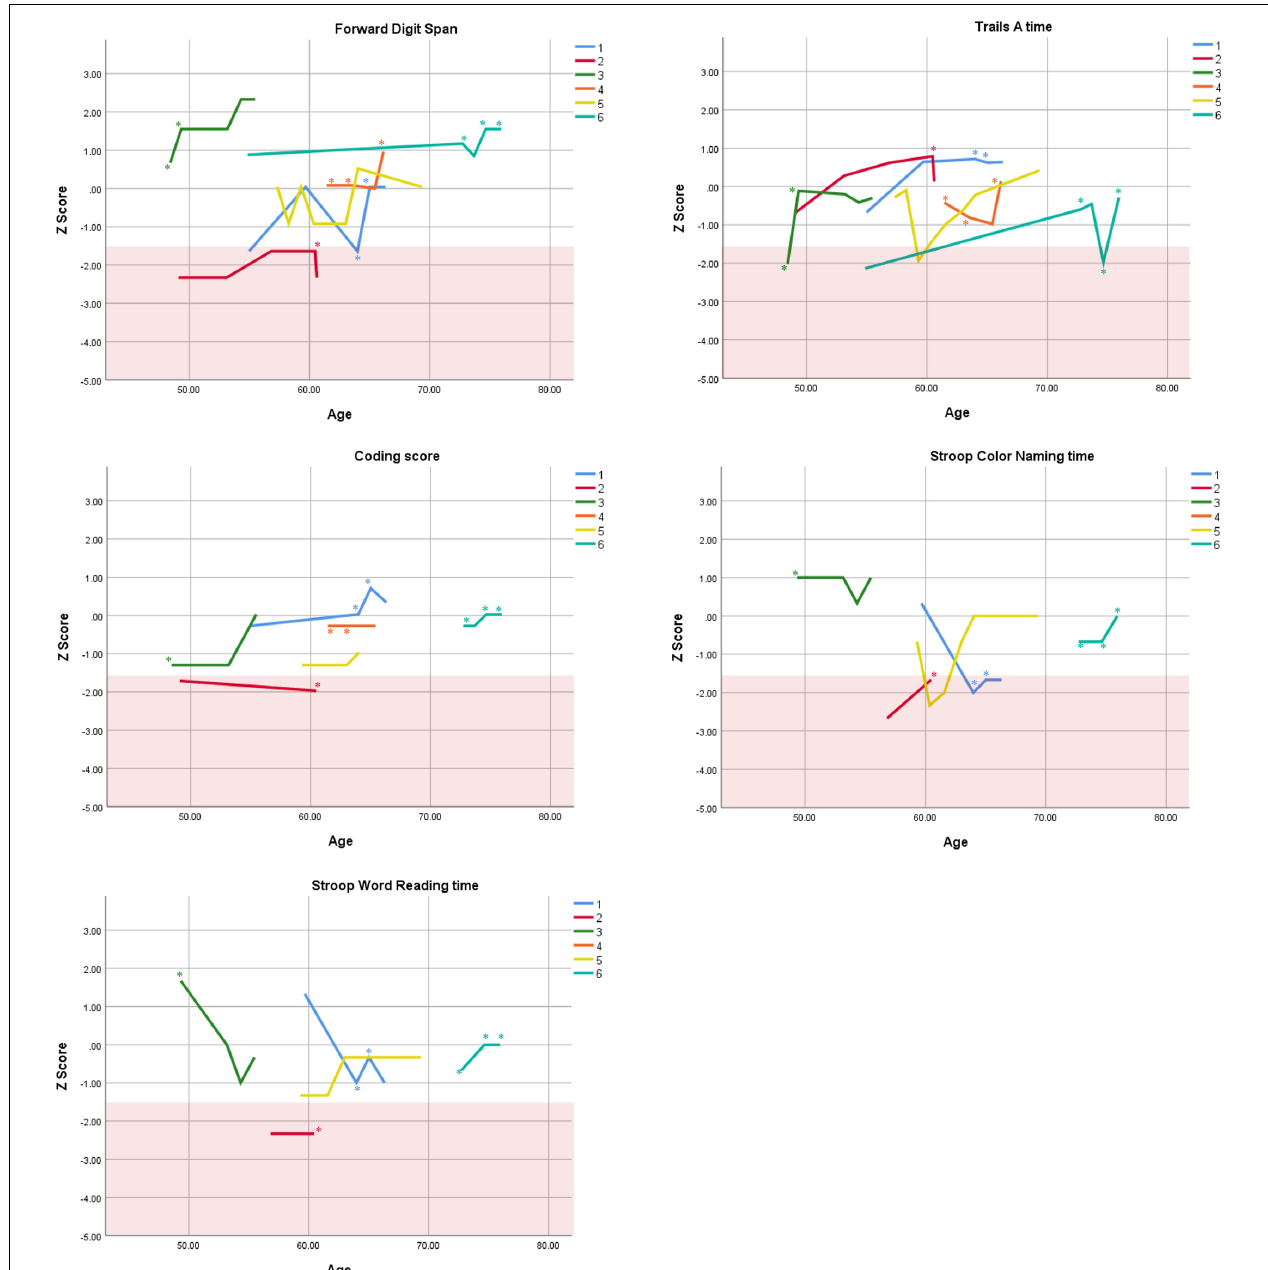
FIGURE 1 | Individual longitudinal performance on measures of attention. Shaded red area represents impaired performance ( Z < –1.5). *Denotes clinically significant depressive symptoms at that visit (30-item GDS ≥ 10 or BDI-II ≥